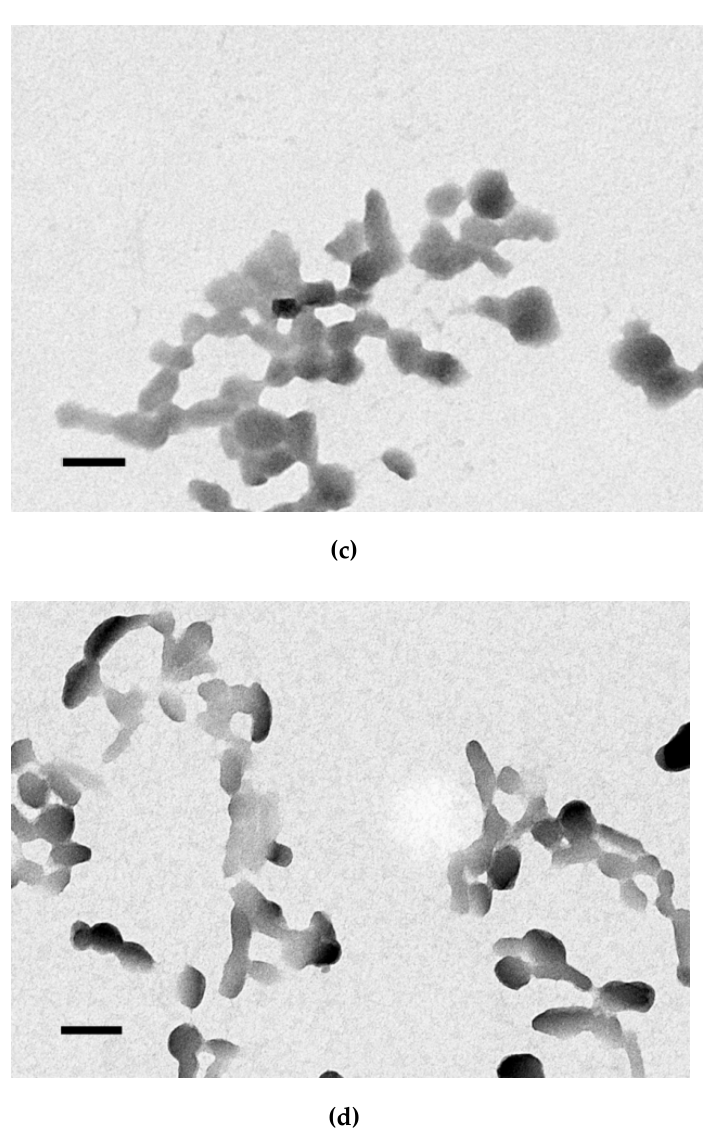
Figure 5. Typical microphotographs of the carrier/DNA complexes obtained by transmission electron microscopy: ( a , b ) RGD1-R6-polyplexes and ( c , d ) RGD0-R6-polyplexes formed at N/P ratios 8/1 and 12/1, respectively. The scale bar corresponds to 100